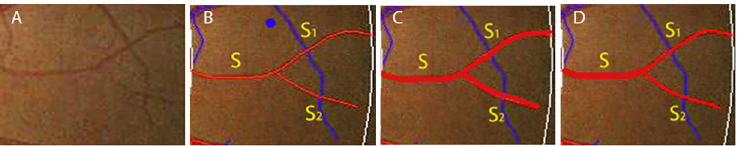
Fig 2. Diagrammatic illustration of branching coefficient. A portion of the retinal arteriole nasal to the disc is shown, pre (panel A) and post-processing (panel B) by SIVA. Branching coefficient (BC) is calculated as BC ¼ ð S 2 1 þ S 2 2 Þ where S is the root, or main segment of vessel, and S 1 and S 2 are its branches. Note the relative thicknesses of the main segment of the vessel compared to its branches, as artificially illustrated in panel C and D. A higher BC reflects similarly sized vessel diameters between the main vessel and its branches (panel C), while a lower BC is related to a decrease in the diameters of the branches compared to the main vessel (panel